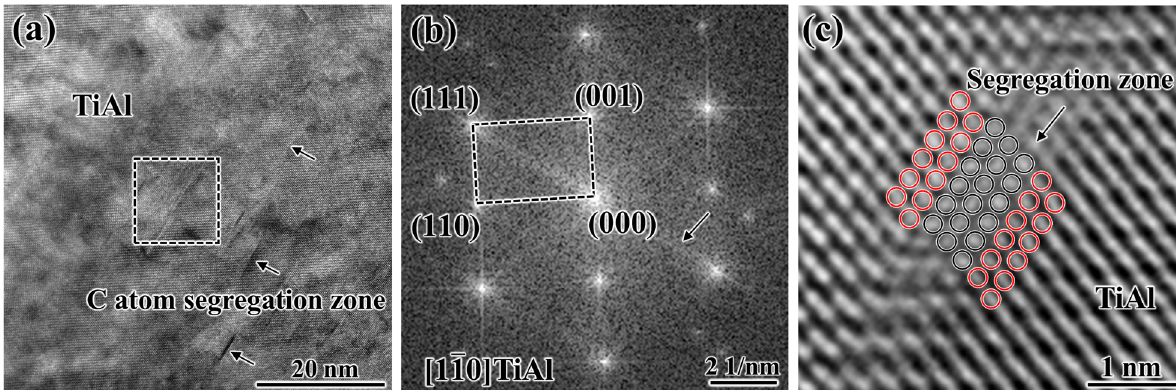
Figure 2: The TEM analysis of C atom segregation in TiAl alloys. ( a ) HRTEM image of segregation zone; ( b ) FFT pattern; and ( c ) IFFT image of segregation